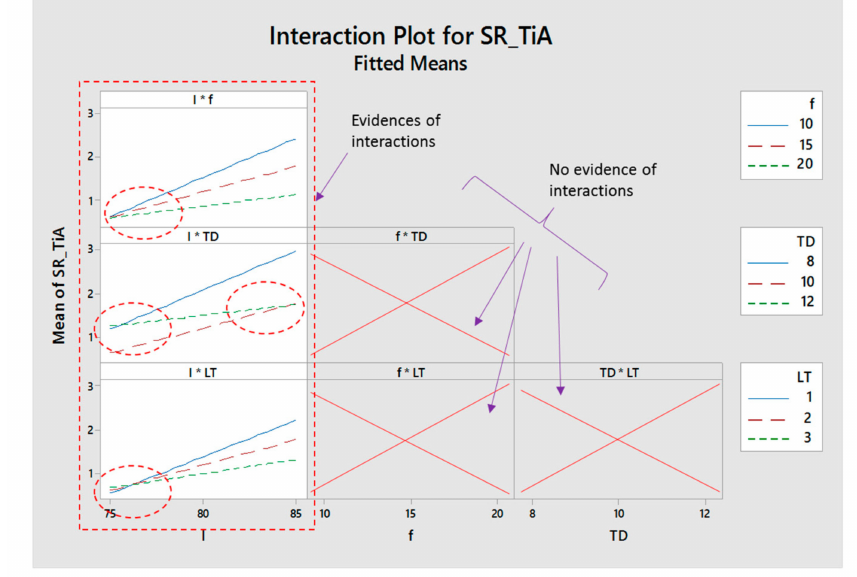
Figure 5. Interaction plot for titanium